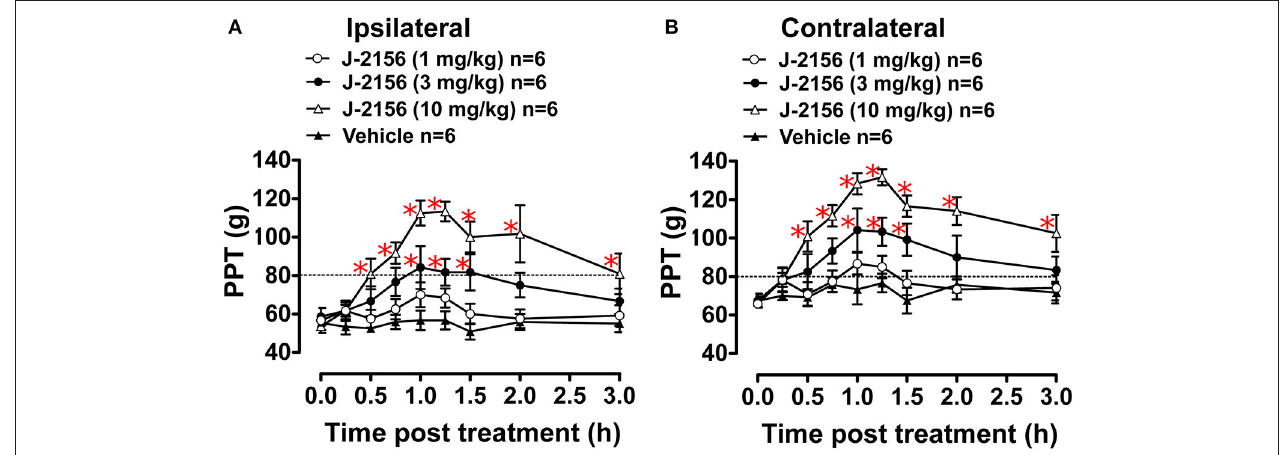
FIGURE 4 | Anti-hyperalgesic effect of single bolus doses (i.p.) of J-2156 on ipsilateral and contralateral hindpaw pressure thresholds (PPTs) in BCIBP rats. Panels in the figure show (A) ipsilateral PPT vs. time curves and (B) contralateral PPT vs. time curves. The dotted line shows the threshold criterion of fully developed mechanical hyperalgesia ( ≤ 80g). Red asterisks * p ≤ 0.05 [ipsilateral: F (3,8,24 / 160) = 15.0, 10.1, 3.1; contralateral: F (3,8,24 / 160) = 19.3, 13.2, 2.5; Two-way ANOVA, post-hoc Bonferroni test c.f. BCIBP-rats administered vehicle]. Between-dose differences ( p ≤ 0.05) in the PPT values were also